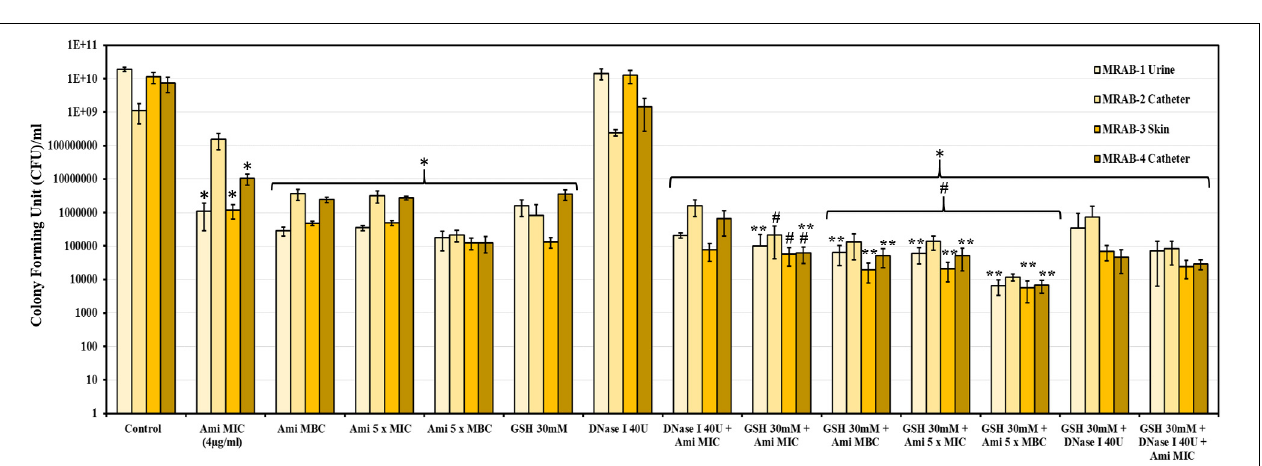
FIGURE 6 | CFU count of MRAB biofilms after GSH, amikacin and DNase-I treatment: CFU/ml of control, amikacin, DNase-I and GSH of MRAB isolates was log 10 9–10.2, log 10 5.1–8.2, log 10 8.3–10.2 and 5.1–6.5, respectively. Combination treatments comprising: DNase-I + amikacin, GSH + amikacin and GSH + DNase-I on biofilms resulted in a CFU/ml of log 10 4.9–6.2, 3.7–5.3, and 4.6–5.9, respectively. The triple combination of GSH + DNase-I + amikacin decreased the CFU/ml to log 10 4.3–4.9. Data represent the mean ± SD of n = 3 experiments performed in biological replicate. ∗ P < 0.05 compared to control, # P < 0.05 when compared to amikacin vs. GSH + amikacin and ∗∗ P < 0.05 when compared to GSH vs. GSH + amikacin.